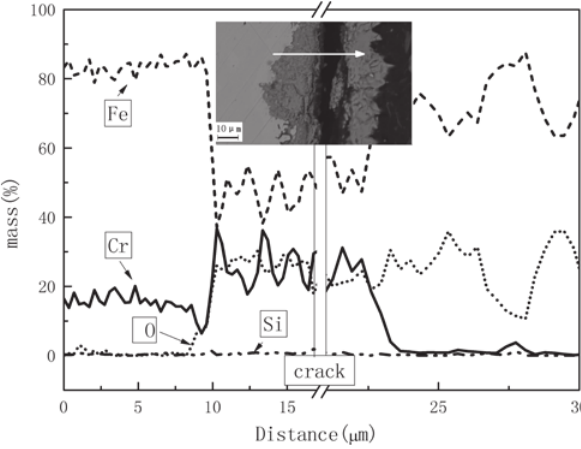
Fig. 8: Elements contents of the cross section of oxidized Fe-16Cr alloy exposure in dry air at 1000 °C for about 40 min obtained by